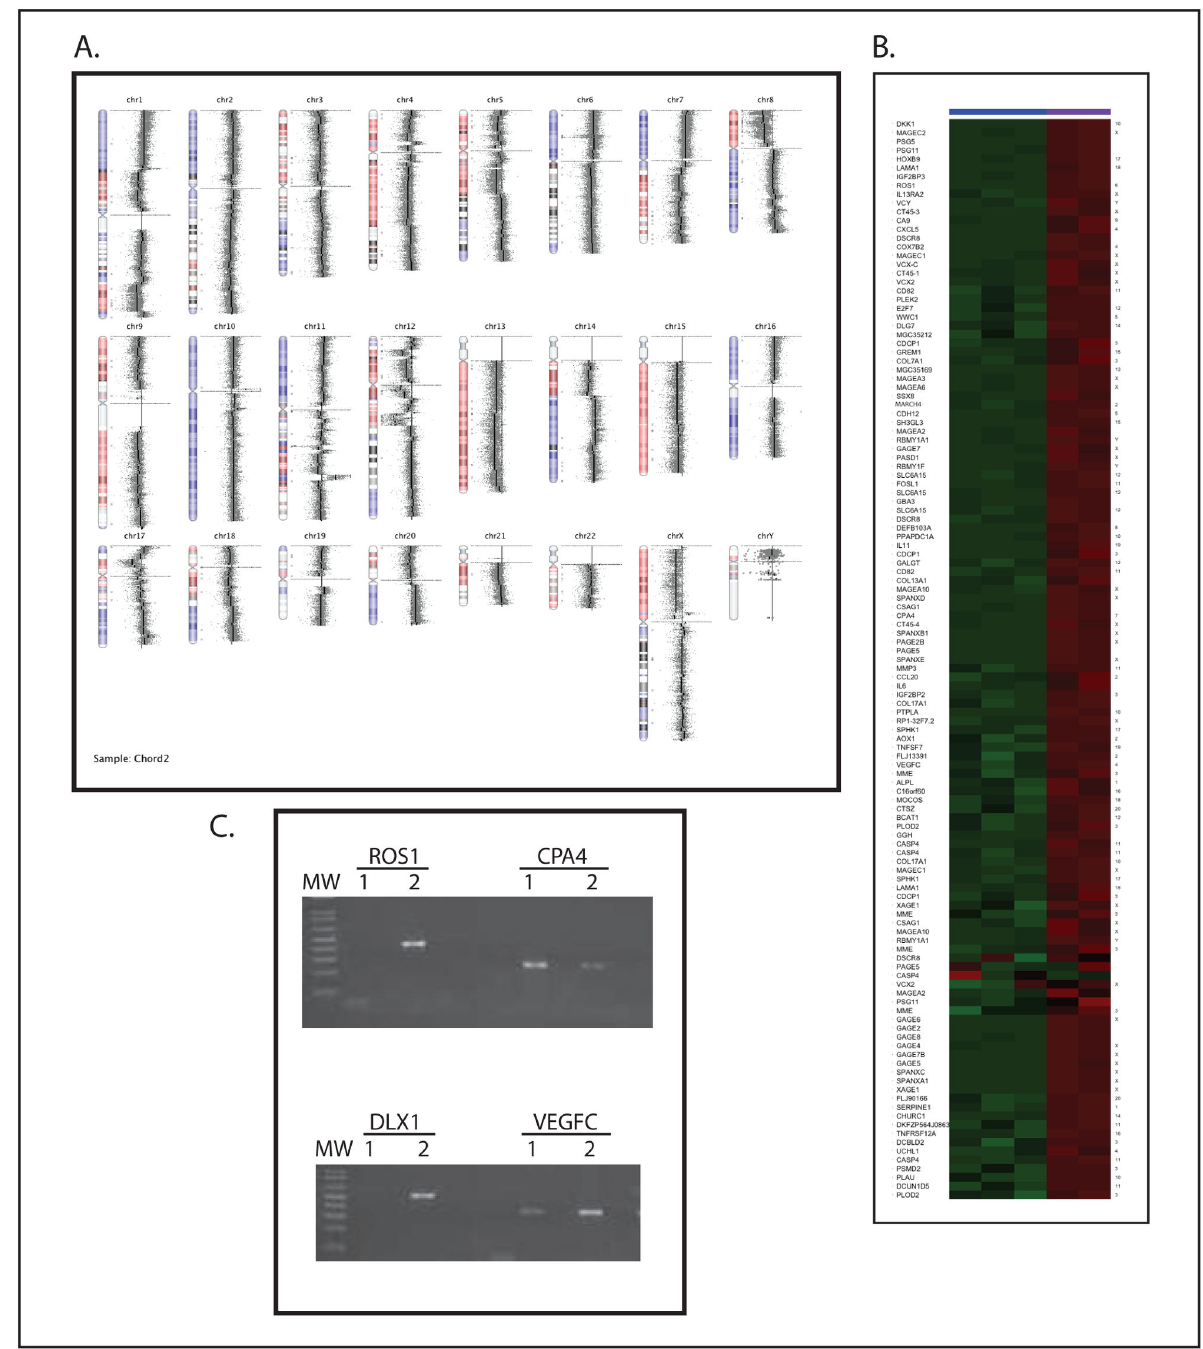
Figure 3. A) SNP-genotyping showing significant loss of heterozygosity throughout the genome. B) A heatmap showing relative expression of the 100 genes most strongly overexpressed in the xenograft compared with classic chordomas. Chromosome location of each gene is denoted along the right side. Green represents relative underexpression, and red represents relative overexpression. The three columns on the left are data from the comparison chordomas, and the two columns on the right are from the xenograft. C) RT-PCR confirmation of gene expression in the xenograft. cDNA reverse transcribed from RNA isolated from the xenograft and from the JHC7 cell line was amplified with primers for the indicated genes. Lanes 1 are reactions using RNA from JHC7, and Lanes 2 are reactions using RNA from the xenograft. Ribosomal RNA 36B4 was used as a positive control to confirm cDNA integrity (data not shown). doi: 10.1371/journal.pone.0079950.g003 PLOS ONE |